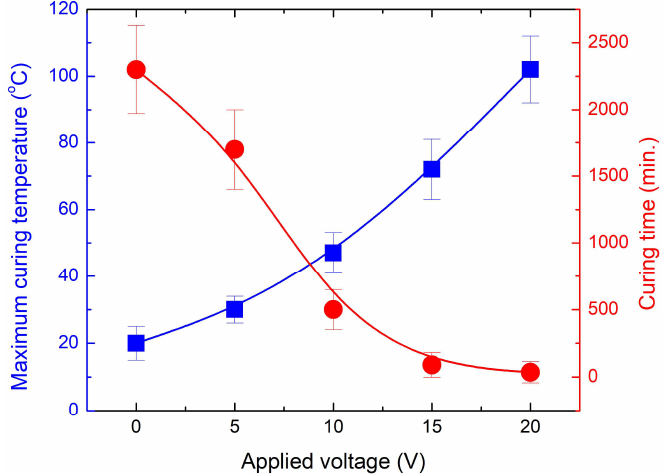
Figure 6. Infrared images showing temperature distributions of CNT nanocomposites cured at different voltages: ( a ) 5 V; ( b ) 10 V; ( c ) 20 V.